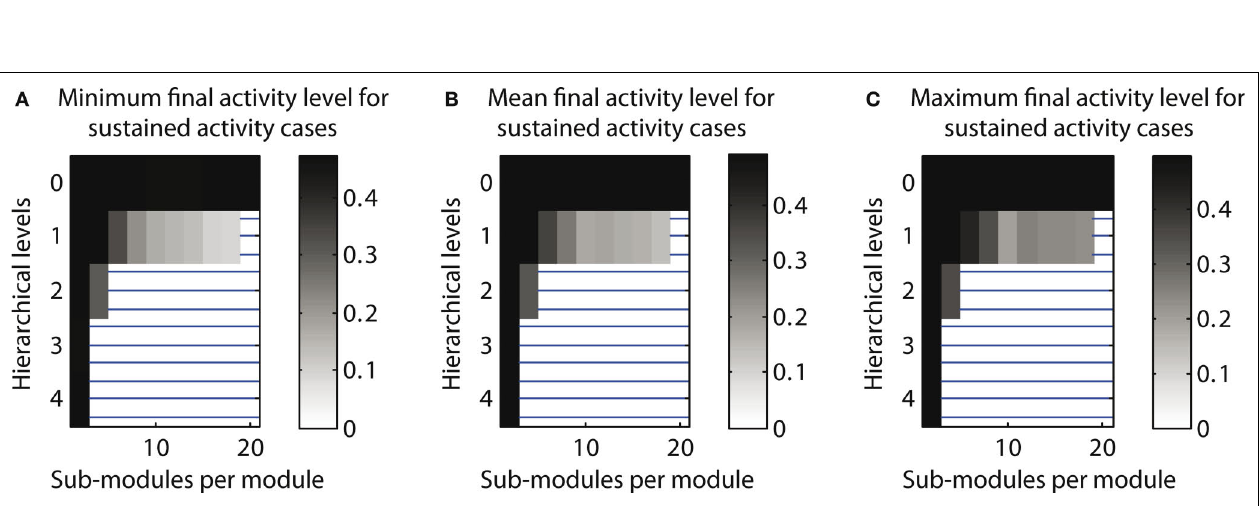
FIGURE 8 | Varying the parcellation (number of sub-modules per module) for hierarchical levels. (A) Decreasing number of sub-modules m ∼ 0.9 i ). (B) Parcellation into sub-modules independent from hierarchical level ( m hierarchical levels ( m i ∼ 1.1 i ). modules m for higher hierarchical levels ( m i i